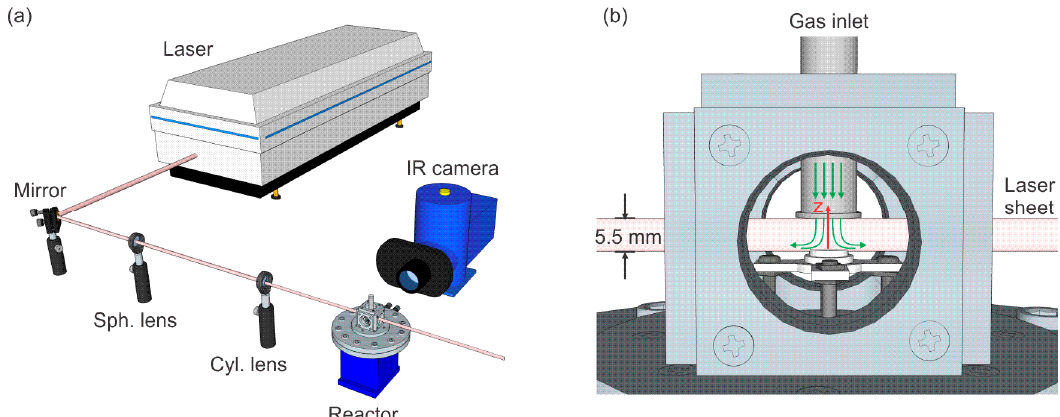
Figure 1. Schematic of the experimental setup: ( a ) overview and ( b ) a close-up of the reactor chamber with the laser sheet. The green arrows show the flow schematically, and the red arrow indicates the z-axis in the modeling.